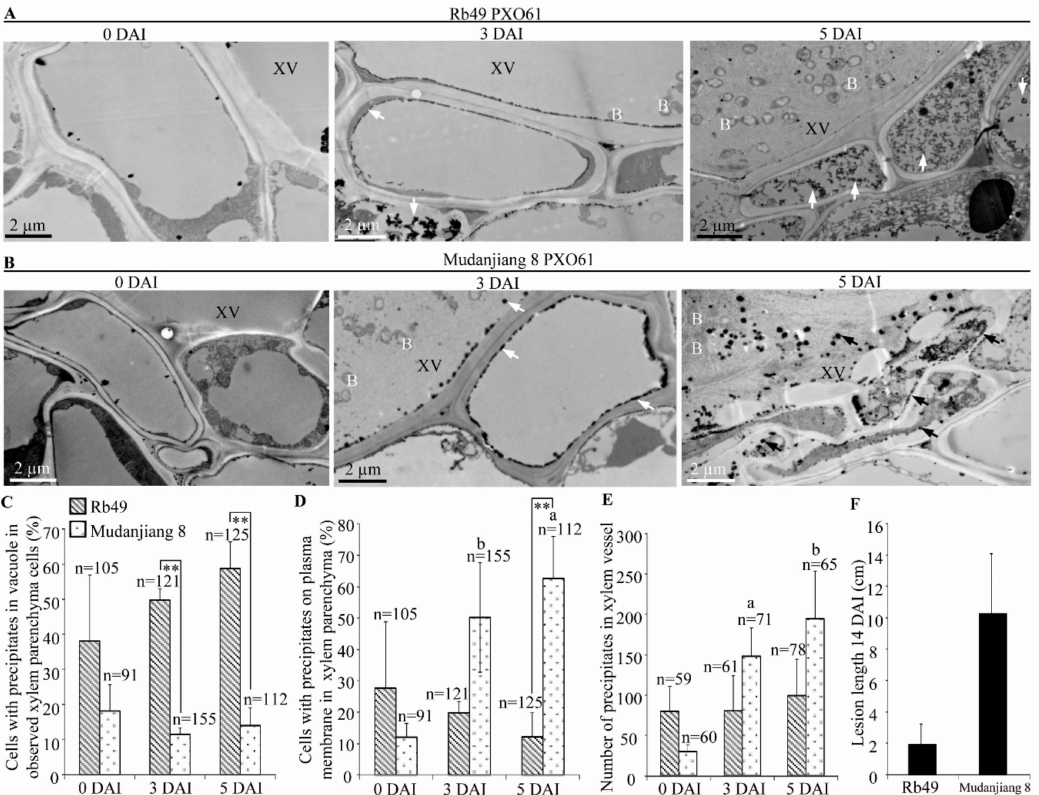
Figure 8. Calcium ion accumulation induced by Xa3 / Xa26 in vacuole of xylem parenchyma cell. XV, xylem vessel; B, Xoo bacterium; white arrow and black arrow, high-electron density calcium precipitates. ( A ) Numerous high-electron density calcium precipitates (indicated by white arrow) in vacuole of xylem parenchyma cells in Rb49 plant leaves after inoculation by Xoo strain PXO61 at 3, 5 DAI, in comparison with 0 DAI. ( B ) The gradually increasing calcium precipitates (indicated by white arrow and black arrow) on plasma membrane of xylem parenchyma cell and xylem vessel lumen in Mudanjiang 8 plant leaves at 3, 5 DAI in contrast to 0 DAI. ( C , D , E ) Percentage of cells with calcium precipitates in vacuole ( C ) or on plasma membrane ( D ) of xylem parenchyma cells in all the observed cells, and the number of calcium precipitates in xylem vessel ( E ). Data represent the mean (91–155 xylem parenchyma cell of three xylem veins and 59–78 calcium precipitates of three xylem vessels from three di ff erent plants) + standard deviation (SD); n, the number of all the observed xylem parenchyma cells and the number of all the observed calcium precipitates in xylem vessels. Double asterisks (** p < 0.01) indicate statistically significant di ff erences between Rb49 and Mudanjiang 8 at same inoculation time. The letters “a” and “b” indicate statistically significant di ff erences between 0 day and 3, 5 day in the same rice plant at p < 0.01 and p < 0.05, respectively. ( F ) Lesion length of Rb49 and Mudanjiang 8 leaves infected by Xoo at 14 DAI. Each bar represents mean (10–20 leaves from four plants) +